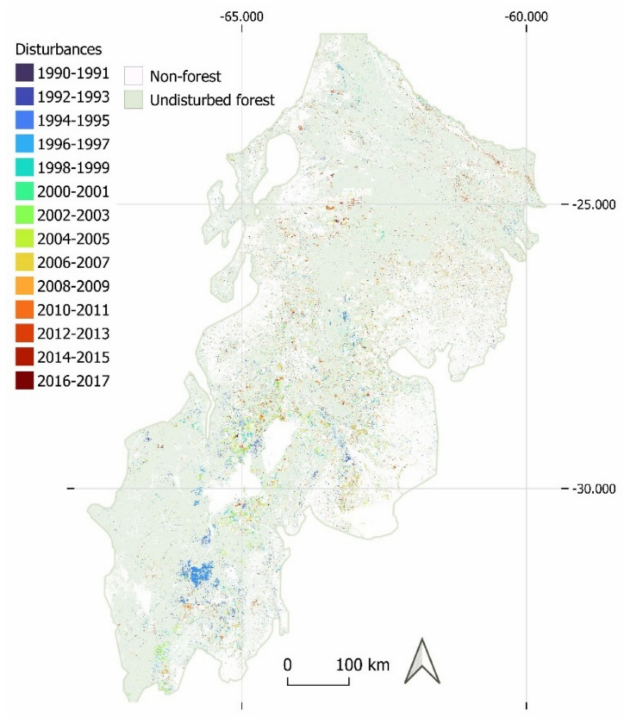
Figure 2. Disturbance map for the Argentine Dry Chaco showing the timing of individual dis- turbed